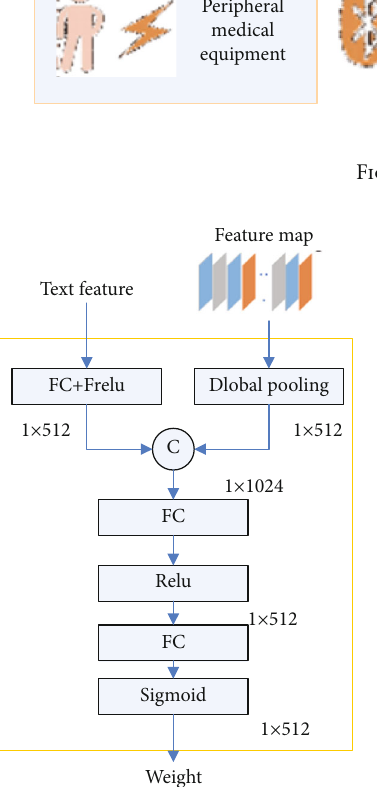
Figure 5: Weight generation module.